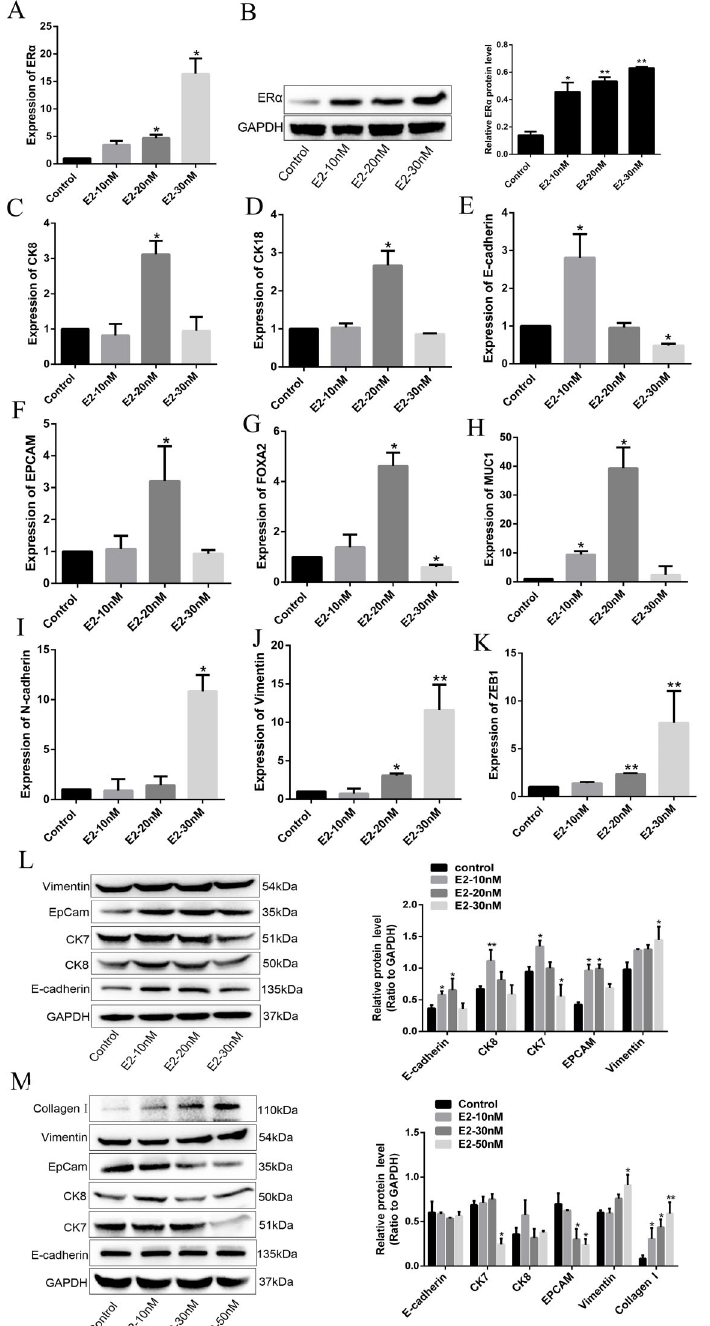
Figure 2. Effects of different doses of estrogen (E2) (10, 20, 30 nM) on epithelial-mesenchymal transition (EMT)-related markers in normal human endometrial epithelial cells (hEECs). A , RT-PCR showing the mRNA expression of estrogen receptor a (ER a ). B , Western blotting showing the protein expression of ER a . C – E , mRNA expression levels of CK8, CK18, and E-cadherin. F – H , mRNA expression levels of anti-epithelial cell adhesion molecule (EPCAM), FOXA2, and MUC1. I – K , mRNA expression levels of mesenchymal markers N-cadherin, vimentin, and ZEB1. L and M , Protein expression of assessed EMT-related markers detected by western blotting with different doses of E2 (10, 20, 30 nM and 10, 30, 50 nM, respectively). Data are reported as means ± SD. *P o 0.05, **P o 0.01 compared to control